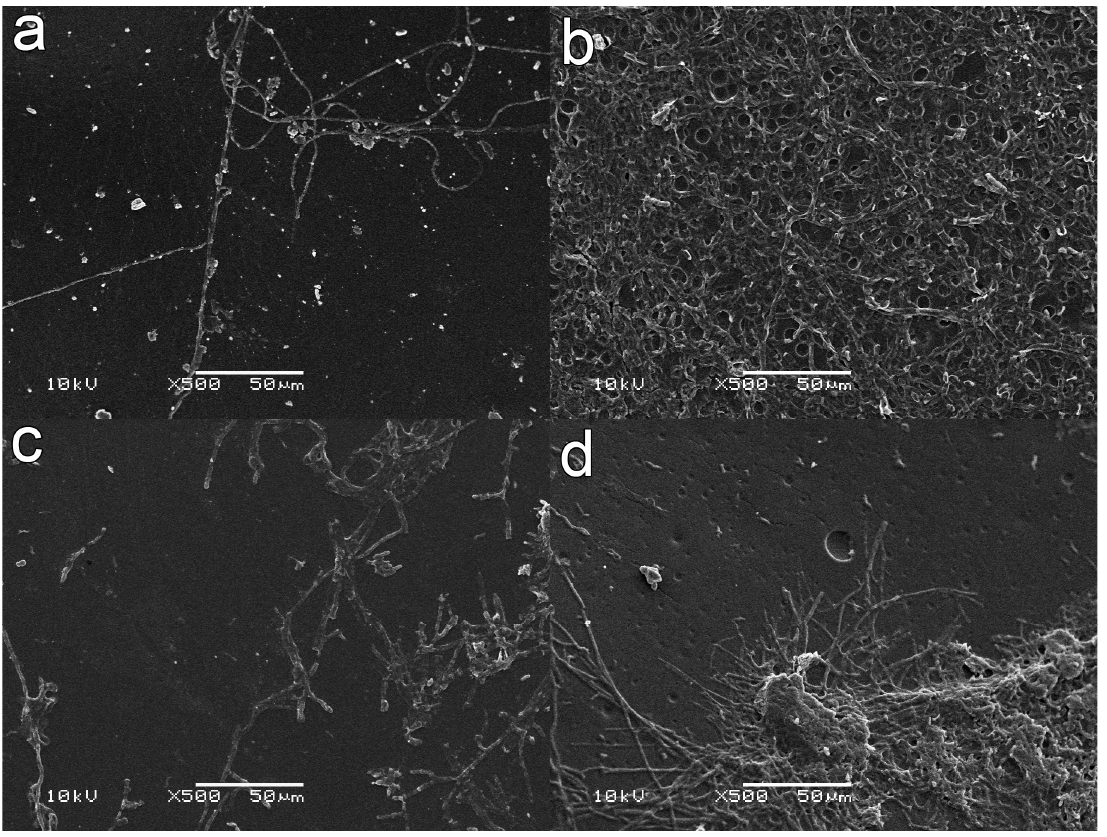
Figure 5. SEM images of PU cultivated in the presence of entomopathogenic fungus Metarhiziumanisopliae for 10 ( a , c ) and 30 days ( b , d ). The films were irradiated with AA vapors for 15 min ( a , b ) and 30 min ( c , d ) before incubation.